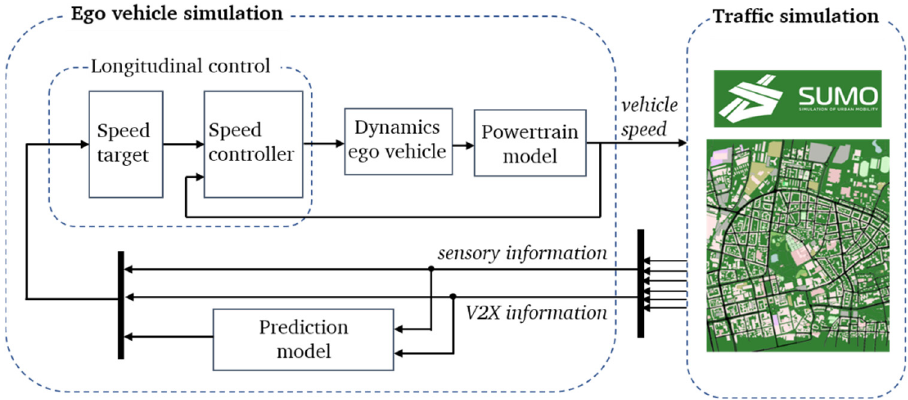
Figure 1. Co-simulation environment consisting of an ego vehicle simulation and a microscopic traffic simulation.